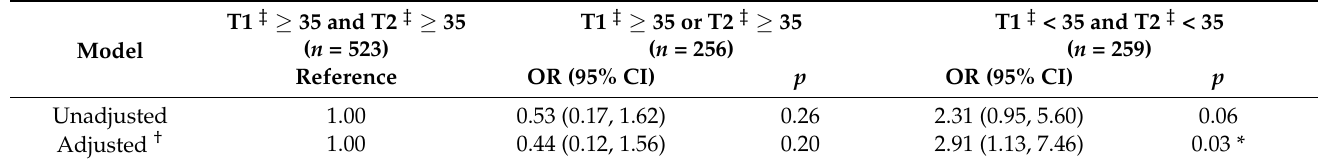
Table 6. Joint effects of 25(OH)D level at two time points on the risk of overweight/obesity in infants at 12